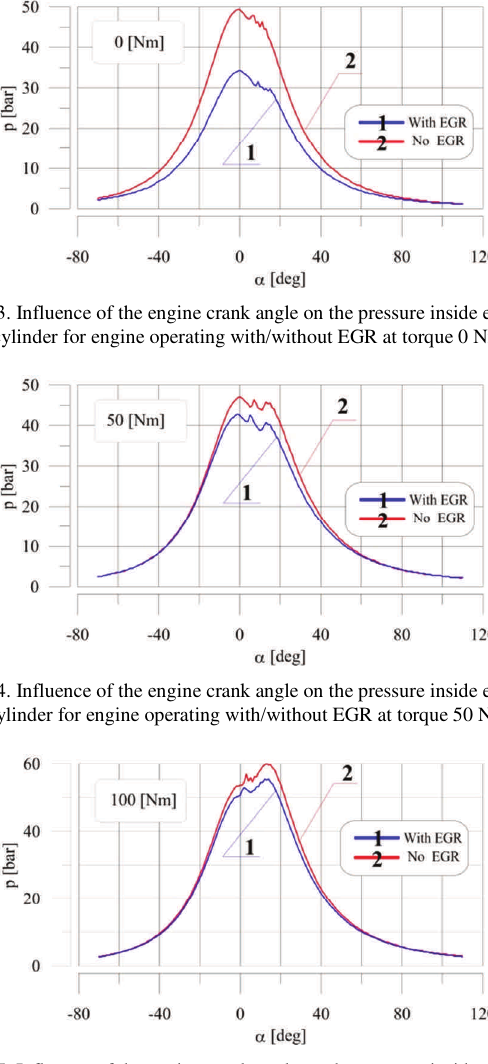
Fig. 5. Influence of the engine crank angle on the pressure inside engine cylinder for engine operating with/without EGR at torque 100 Nm